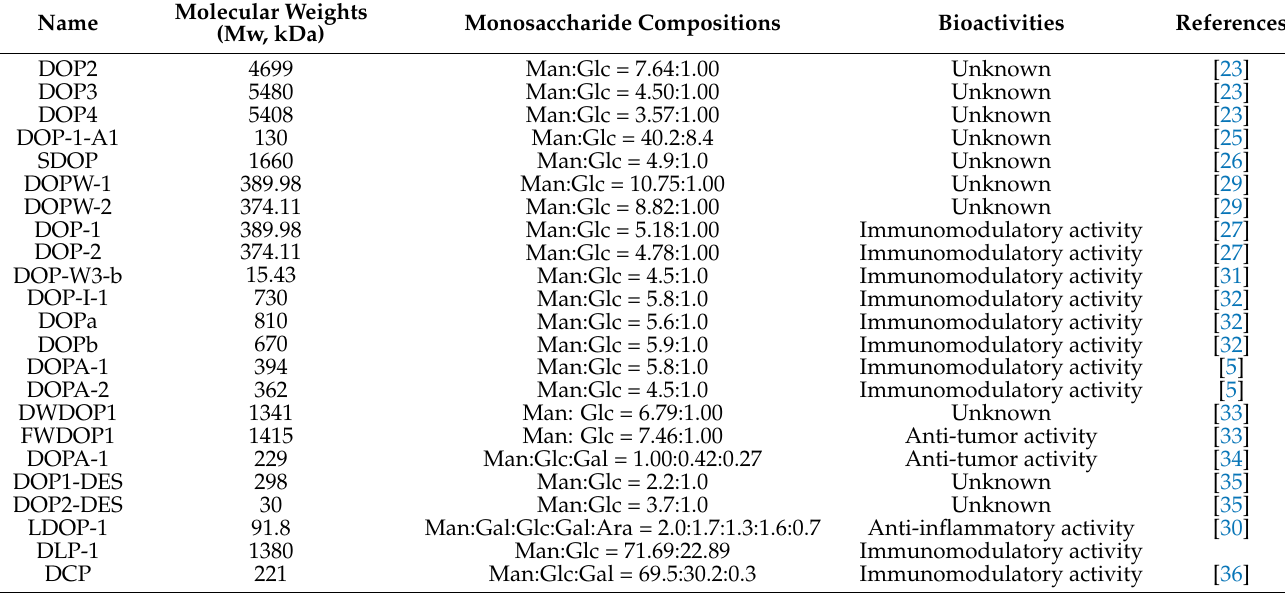
Table 1. Polysaccharides isolated from D. catenatum : monosaccharide compositions, molecular weights, structure unit/backbone chain, and bioactivities.